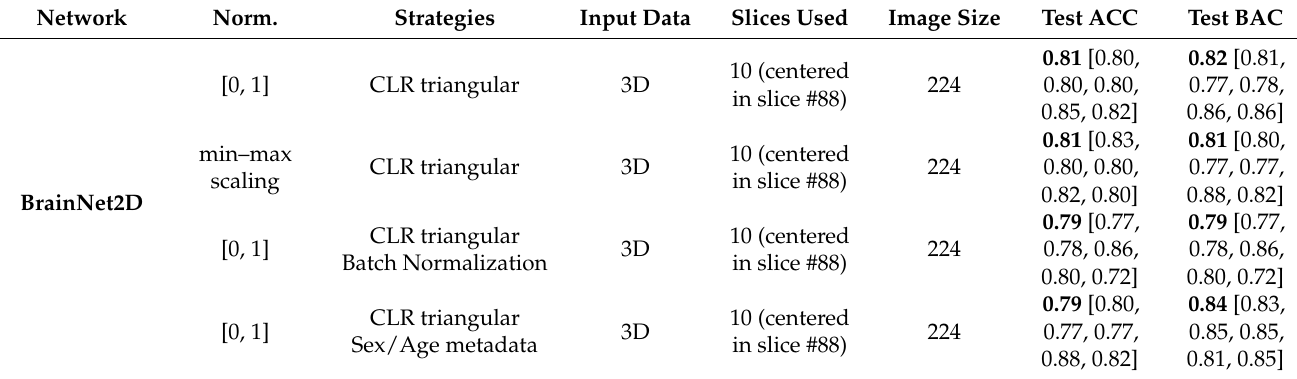
Table 2. Results for two-class classification, CDR = 0 (healthy) and CDR = 0.5, 1, 2 (disease), over the OASIS-1 dataset. Network